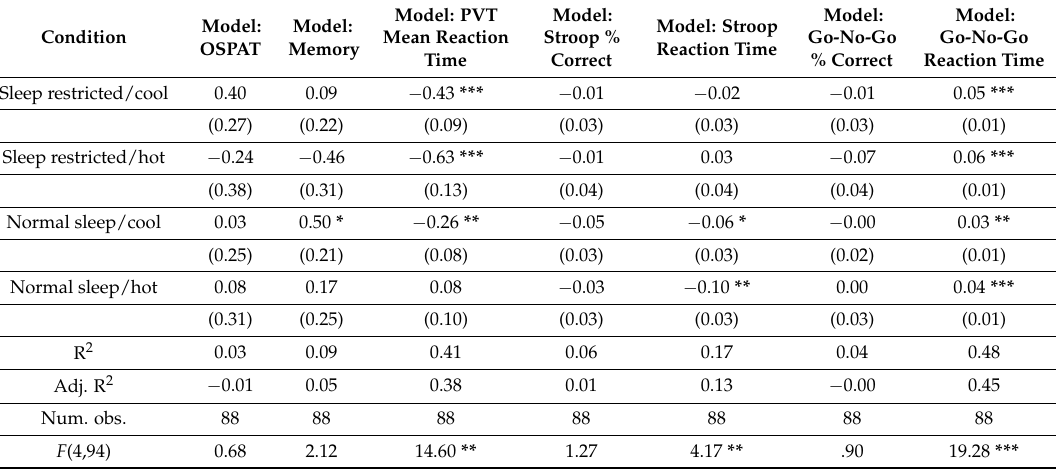
Table 1. ANOVAs predicting changes in outcome scores for objective measures. Models for each outcome (7) were run separately for changes from baseline to test ( Panel A ) and test to recovery ( Panel B ) ˆ . Panel A. Changes baseline to